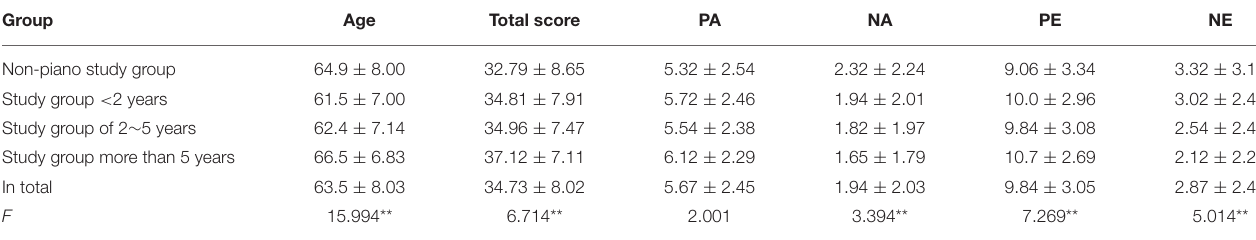
TABLE 4 | The difference between the total happiness score and each factor score of the elderly and the four groups.